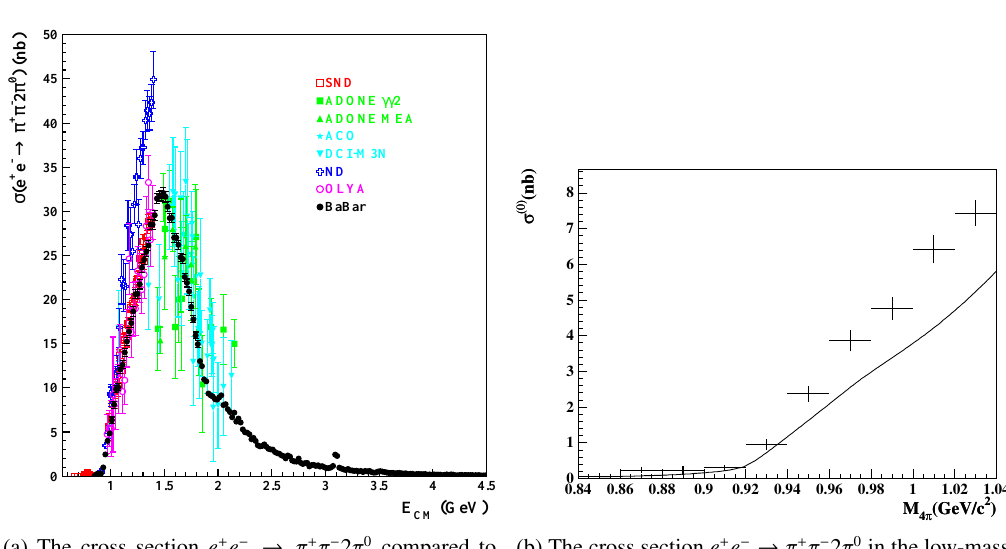
region compared to theory [3]. Figure 2: The cross section e + e − → π + π − 2 π 0